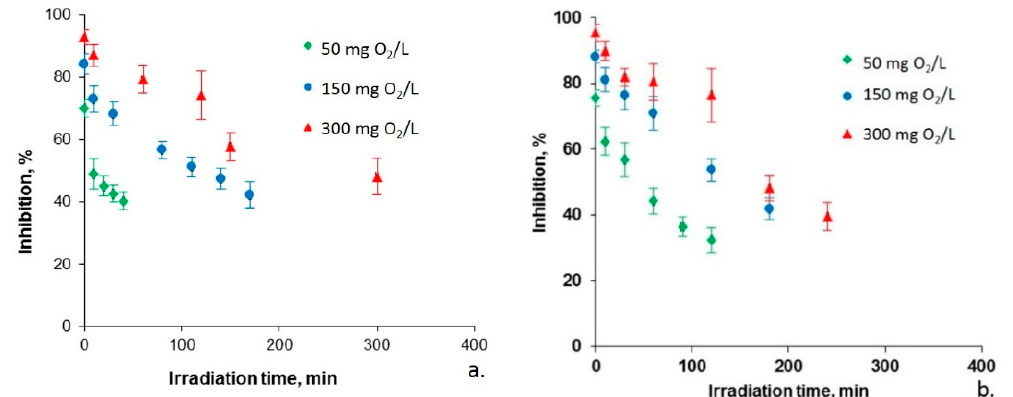
Figure 4. Evolution of the degree of inhibition of activated sludge by chlorophenols and degradation intermediates as a function of irradiation time: ( a ) 4-chlorophenol, ( b ) 2,4-dichlorophenol. Error bars represent the calculated standard deviation for the experimental data.